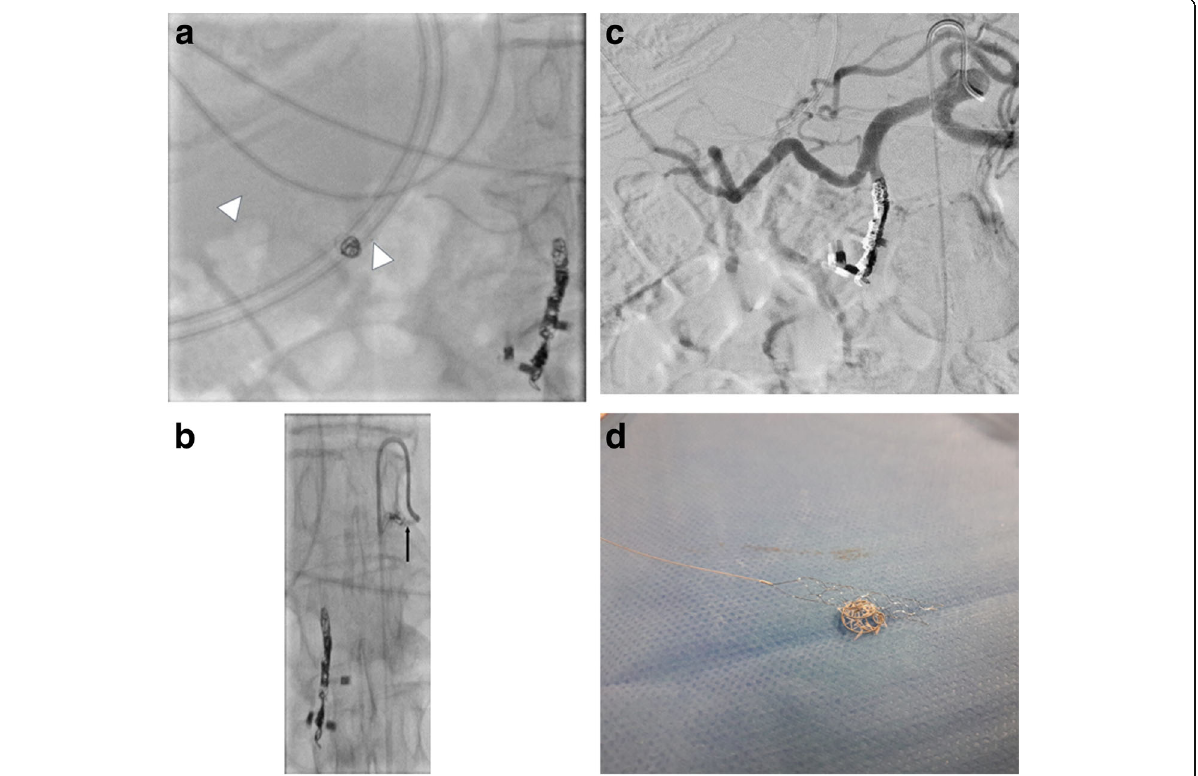
Fig. 1 a pRESET stent retriever placed in the CHA covering the dislocated VortX-Diamond-18 6 × 6.7 mm pushable coil. Markers at both ends of the pRESET are visible (arrow heads) ( b ) advancement of the microcatheter (black arrow) and trapping the coil within the meshwork of the stent retriever by simultaneous pushing the microcatheter and pulling the pRESET. Coil removal by pulling the pRESET and microcatheter into the 5F SIM1-Catheter using gentle repetitive pulling movements ( c ) digital subtraction angiography documents regular flow after coil retrieval ( d ) removed dislocated coil hanging on the stent